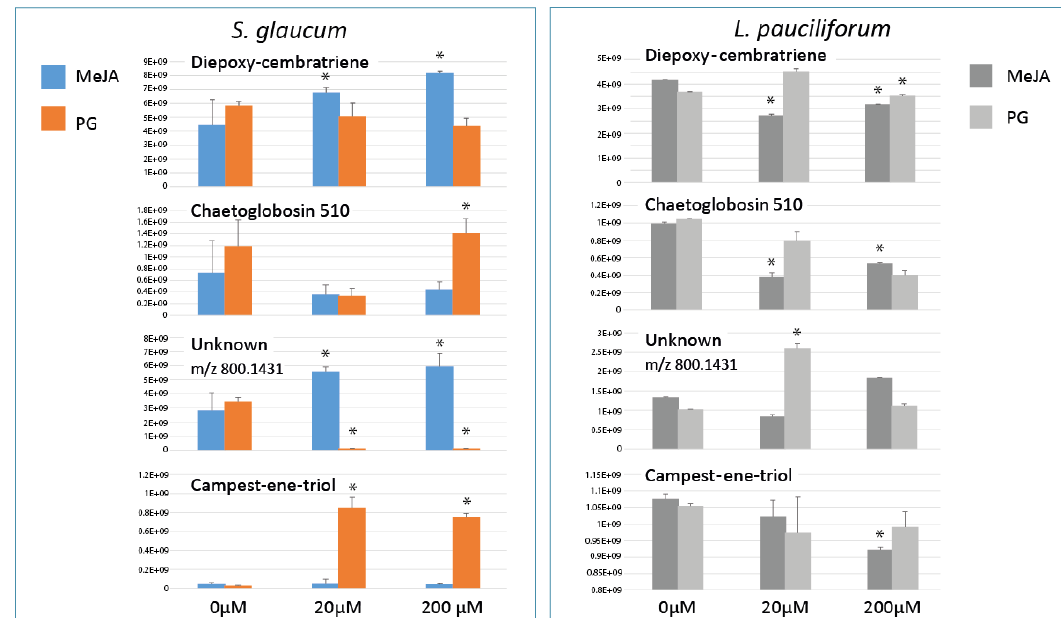
Figure 7. Relative quantification of major terpenoids and sterols in S. glaucum and L. pauciflorum soft corals 24 h post prostaglandin (PG) and methyl jasmonate (MeJA) elicitation at a dose of 20 and 200 µ M. Asterisk indicates significant differences between treatments according to least significant difference (LSD) at p = 0.05.